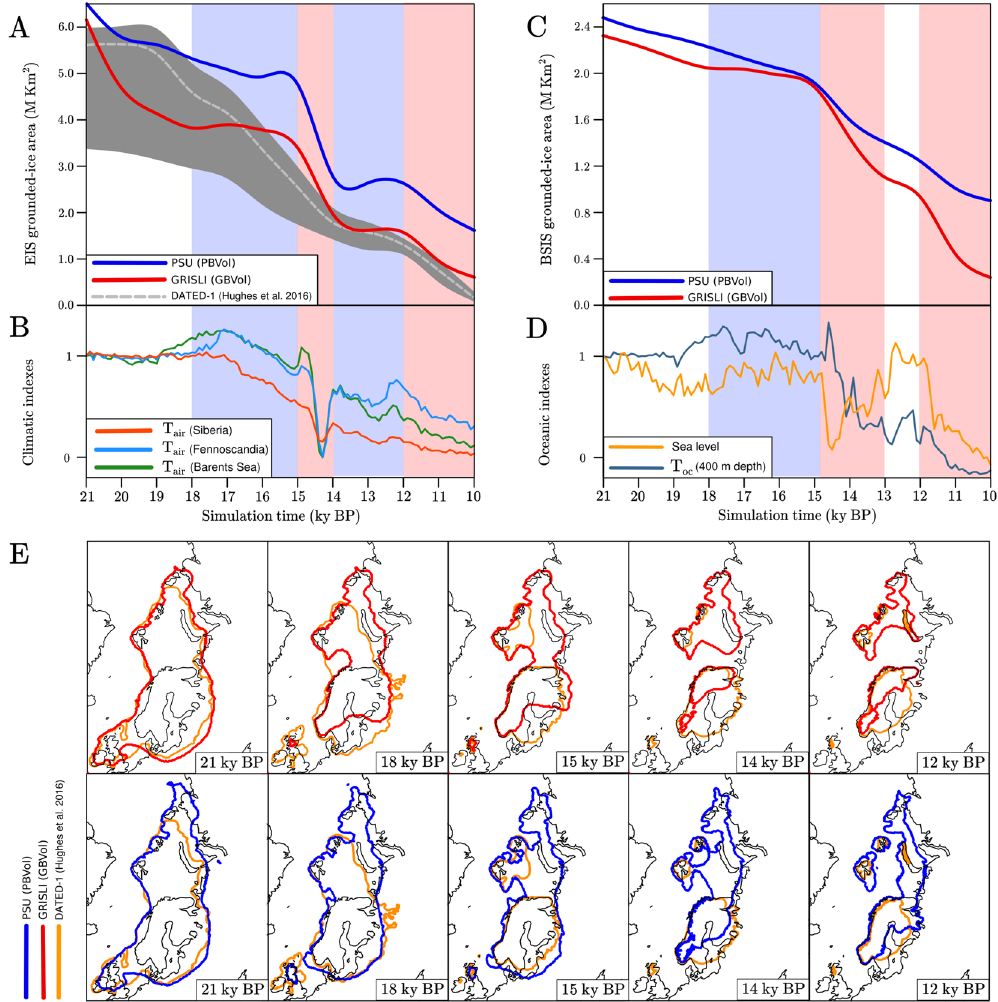
Figure 2. ( A ) Time evolution of the Eurasian Ice Sheet area in GBvol (red line) and PBvol (blue line) simulations. The Eurasian Ice Sheet area evolution during the deglaciation based on the DATED-1 reconstruction 1 is indicated in dashed grey (maximum credibility) and shaded black (minimum and maximum credibility, respectively). Red/blue shades in the background highlight periods of warm/cold annual mean air temperature prescribed in the ISM simulations. ( B ) Mean annual air temperature indexes used to interpolate between LGM and Pre-Industrial (1850 a.d., PI) climate conditions in the ISM simulations ( Material and Methods ), based on the Trace-21ka fully coupled transient simulation 22 . Red/blue shades in the background highlight periods of warm/cold annual mean air temperature prescribed in the ISM simulations. ( C ) Time evolution of the Barents Sea grounded ice area in GBvol (red line) and PBvol (blue line) simulations. ( D ) Indexes for the annual mean ocean temperature in the South-western Barents Sea at 400 m depth (dark blue line) used to interpolate between LGM and PI ocean conditions and for the regional sea level (dark yellow line). The ocean temperature index is based on the Trace-21ka fully coupled transient simulation 22 , whereas the regional sea level index is based on the NGRIP δ 18 O record 29 . Red/blue shades highlight periods of warm/cold annual mean ocean temperature (400 m depth) and high/low global sea level prescribed in the ISM simulations. ( E ) Simulated extent of the Eurasian Ice Sheet in GBvol (red line, top panels) and PBvol (blue line, bottom panels) simulations at different time slices (21, 18, 15, 14 and 12 ky BP). The Eurasian Ice Sheet extent based on the DATED-1 reconstruction 1 is shown in each panel in orange for